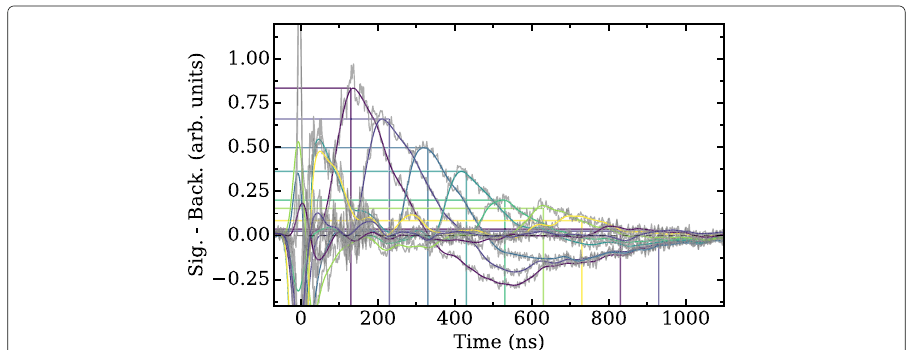
Fig. 4 Difference spectra showing the microwave induced annihilation peaks. The solid curves are obtained after applying a Savitzky-Golay smoothing function to the data. The horizontal lines represent the peak amplitude values obtained from the smoothed data and the vertical lines indicate the corresponding quench